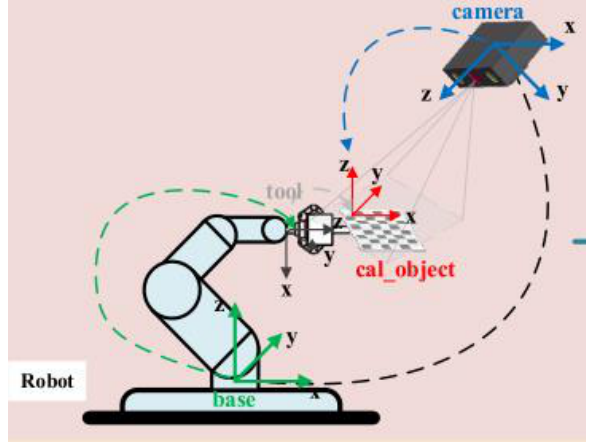
Figure 1. Eye-to-hand diagram